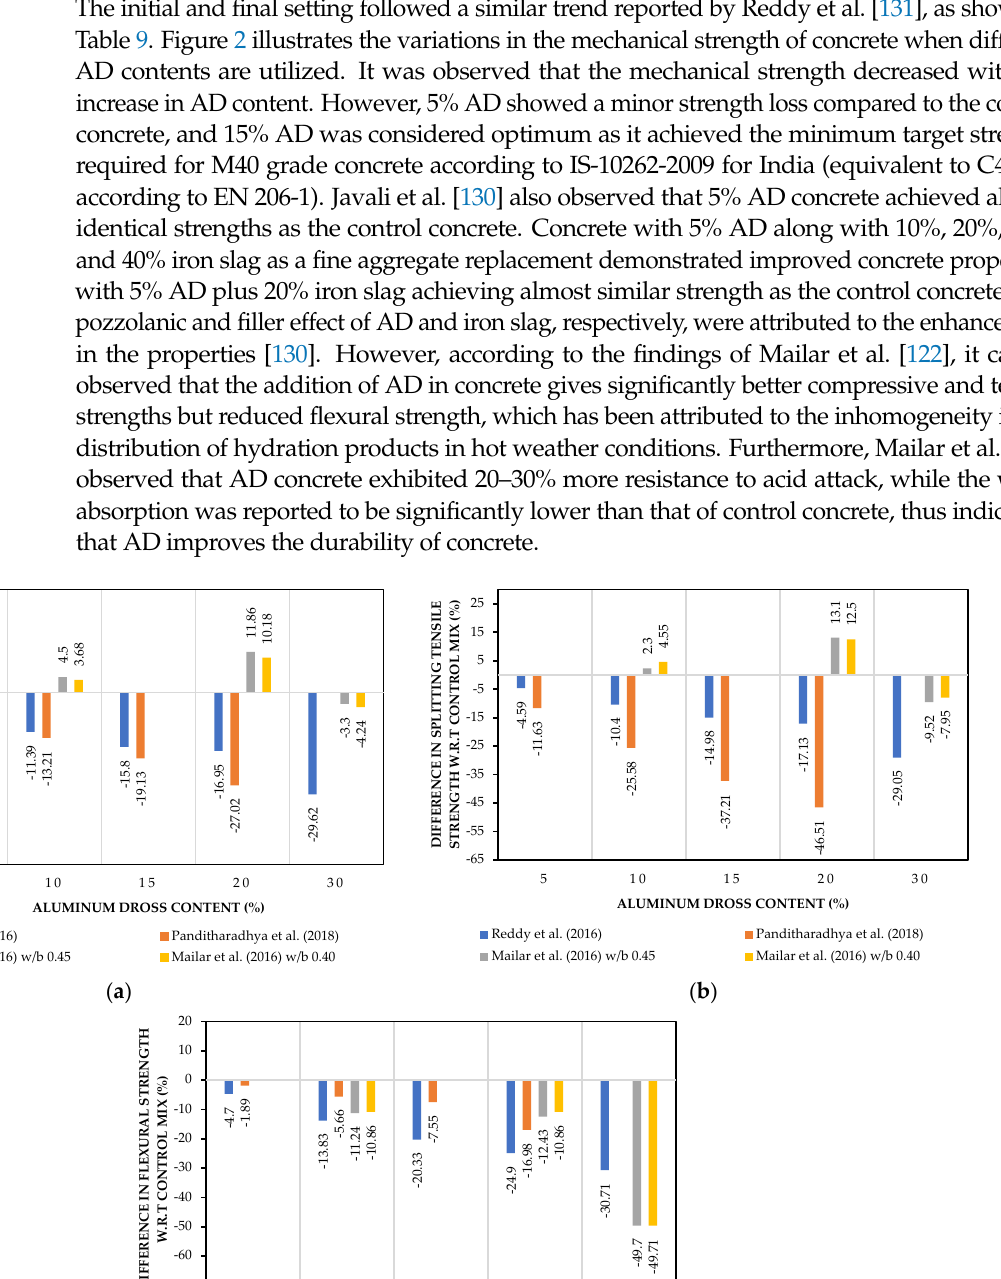
Table 9. Influence of AD on the properties of concrete.